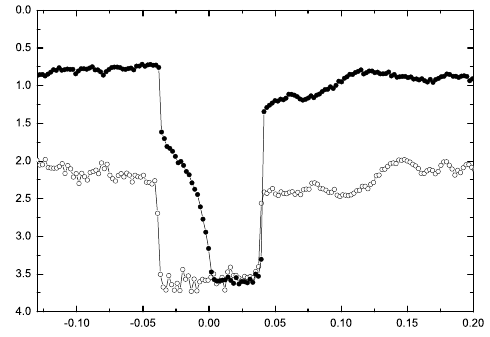
Figure 2: Comparison of two eclipse profiles for HU Aqr at high and low brightness states, respectively. The two eclipse profiles were obtained in 2011 by using the 2.4-m telescope in Yunnan